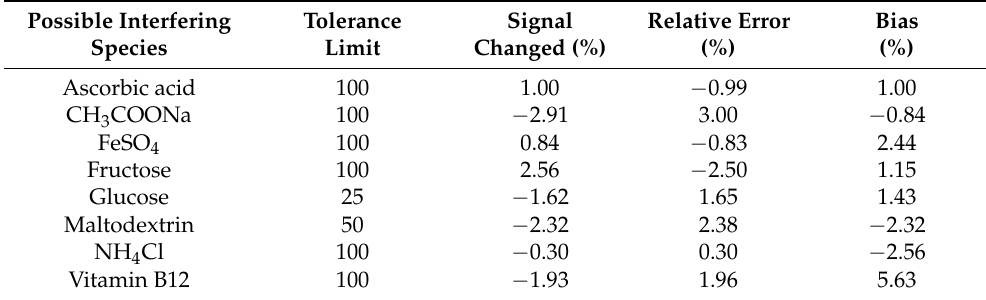
Table 3. The influence of possible interfering species on the detection of 1.0 × 10 − 9 thiamine ( n = 6) using the PIXCoCl/AuNPsnGr